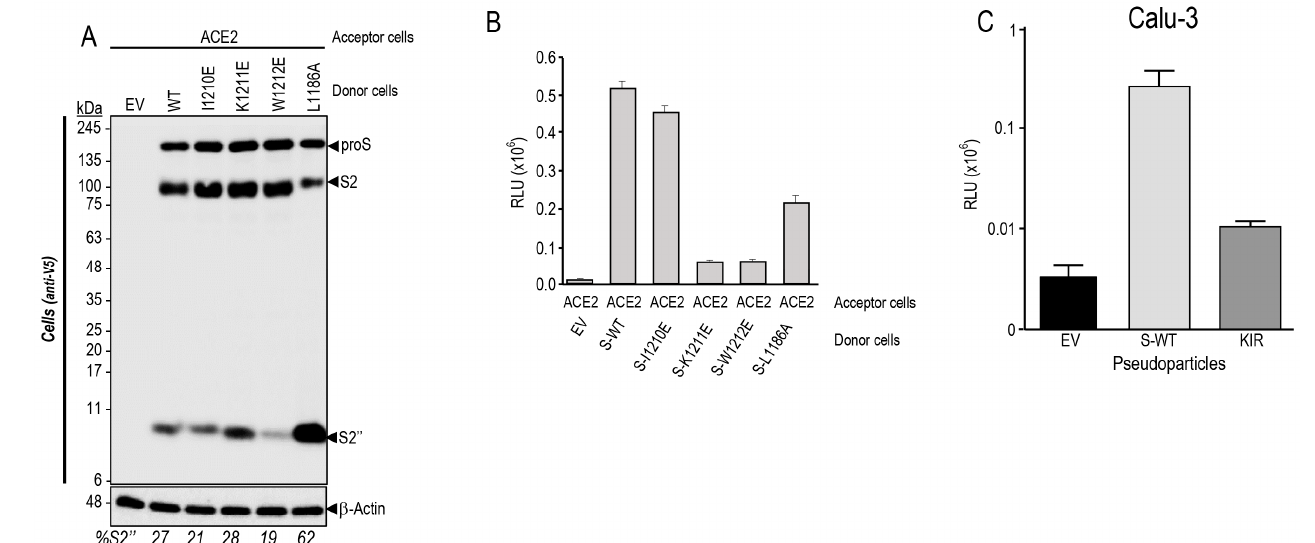
Figure 5. Mutations of proS in HR1 domain prevent cell-to-cell fusion. ( A , B ) Donor Hela cells expressing either no protein (EV), WT-spike (S), or its indicated mutants were co-cultured for 18 h with acceptor TZM-bl HeLa cells transfected with a vector expressing ACE2 receptor. ( A ) Western blot analysis of spike processing in cell extracts. ( B ) Cell-to-cell fusion: the extent of fusion is represented as relative luminescence units (RLU). ( C ) Impact of KIR mutation on pseudoparticle entry in Calu-3 cells.